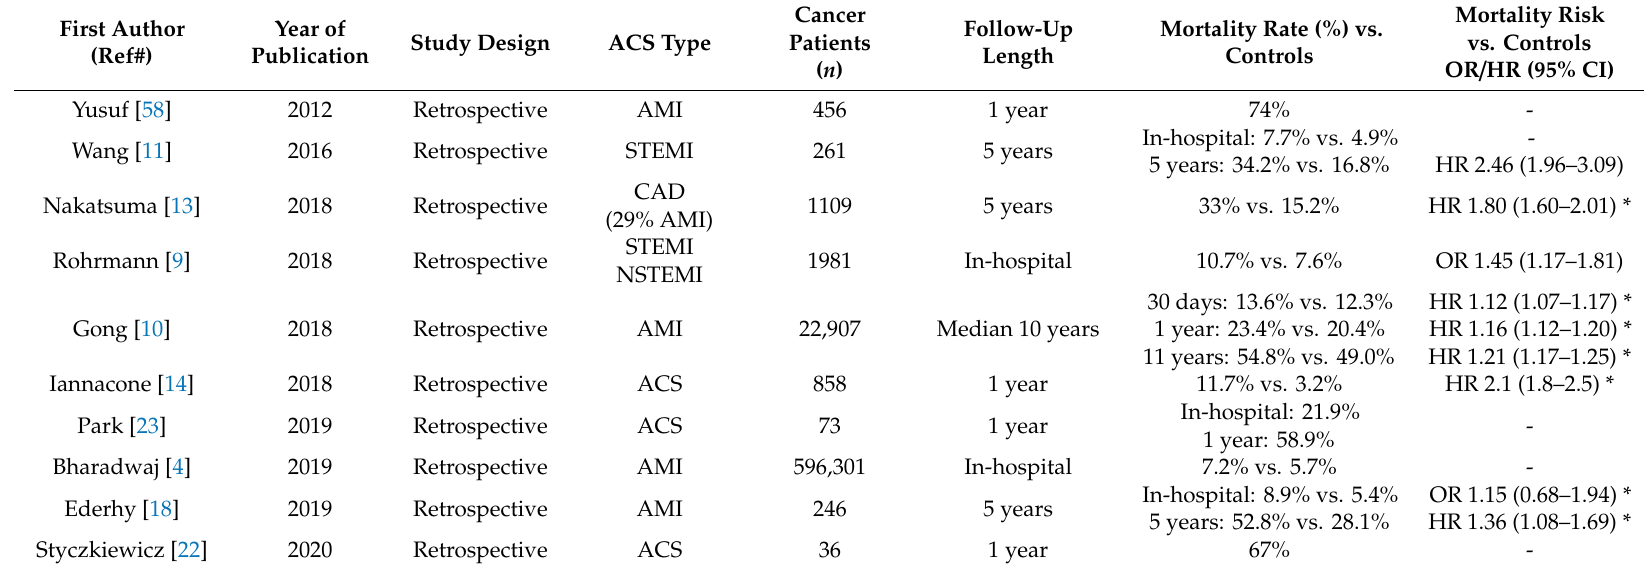
Table 2. Characteristics of studies investigating the prognostic impact of cancer in patients with acute coronary